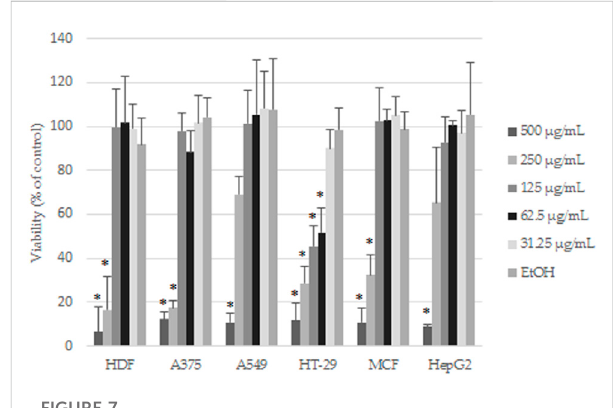
FIGURE 7 Effects of EAE on the cells viability after 48 h of treatment.